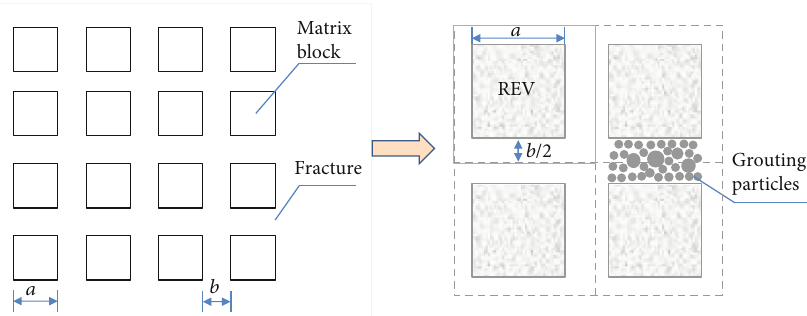
Figure 2: Sketch of the physical model for broken coal with